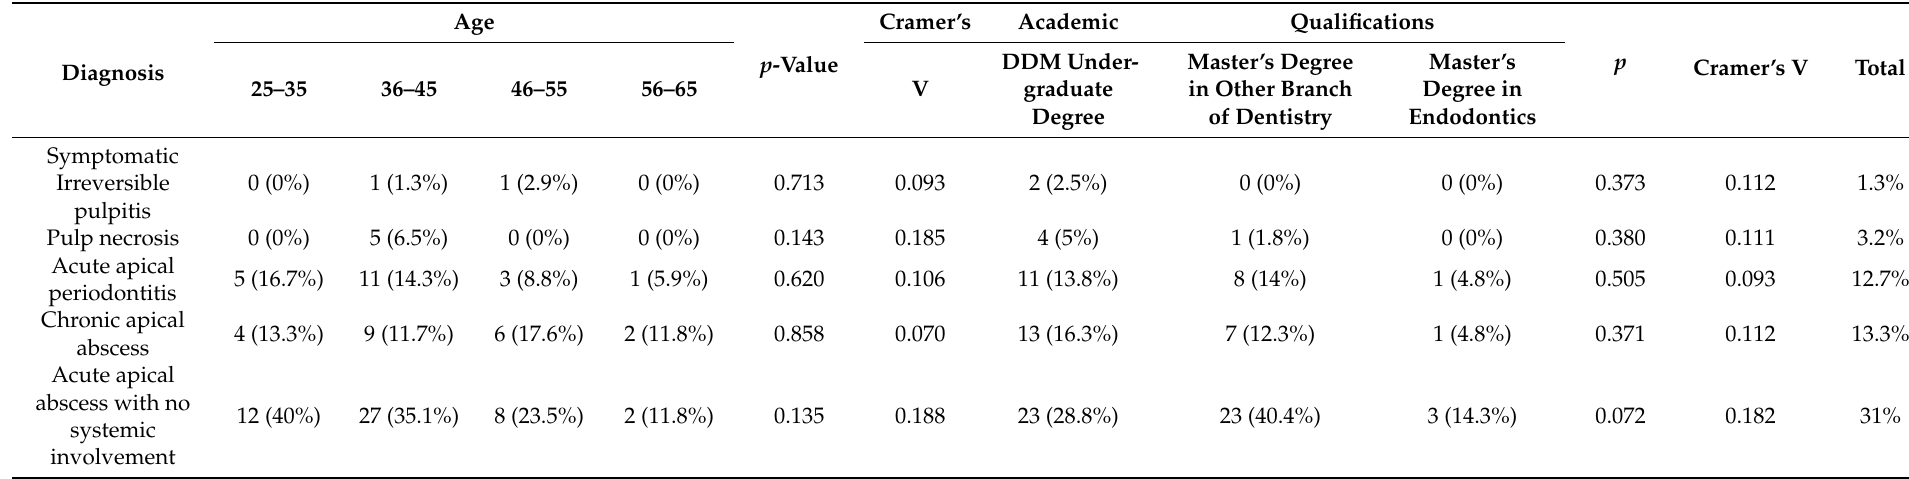
Table 4. Antibiotic use for different clinical indications according to the participants’ age and academic qualifications (statistically significant differences are highlighted in